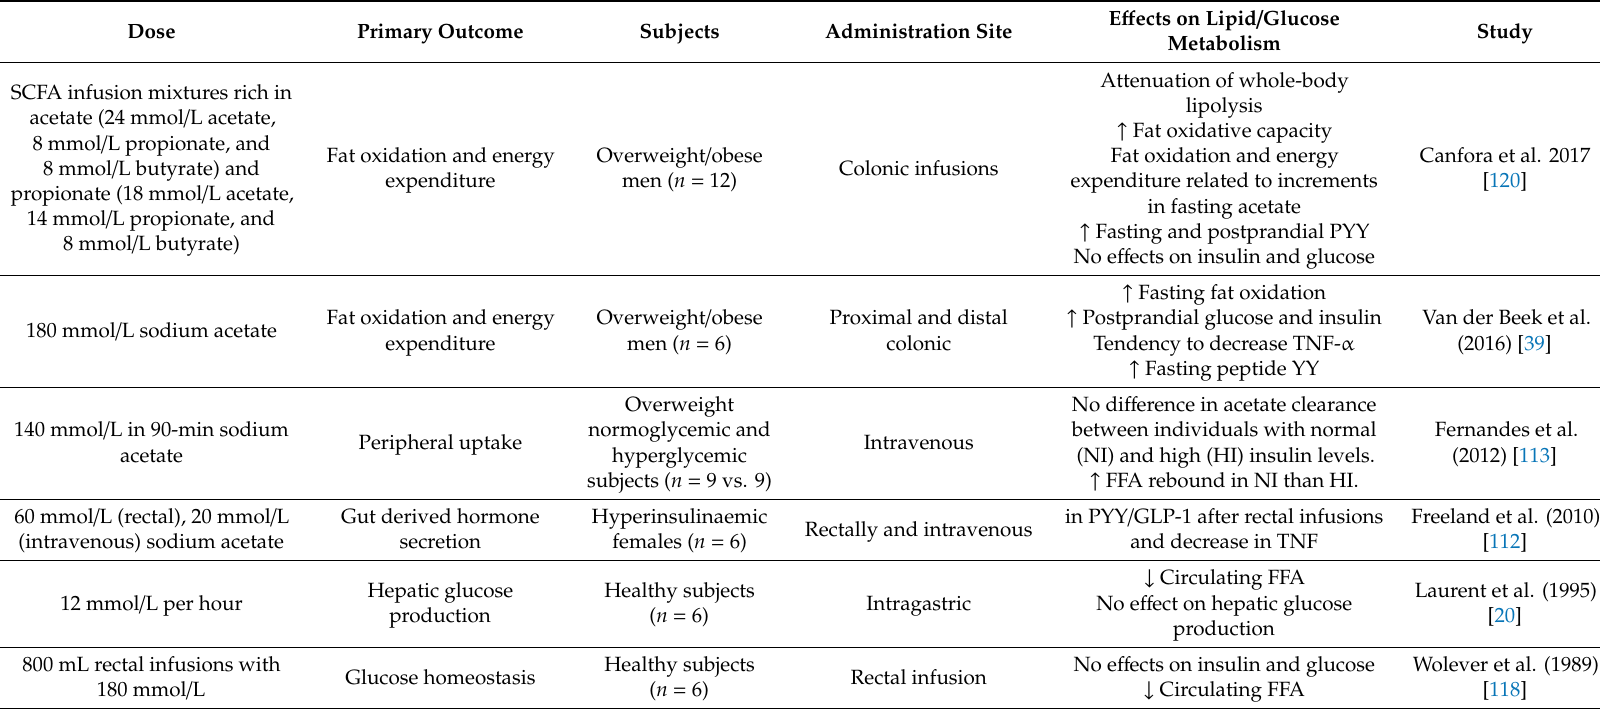
Table 2. E ff ects of sodium acetate infusions in humans at di ff erent administration